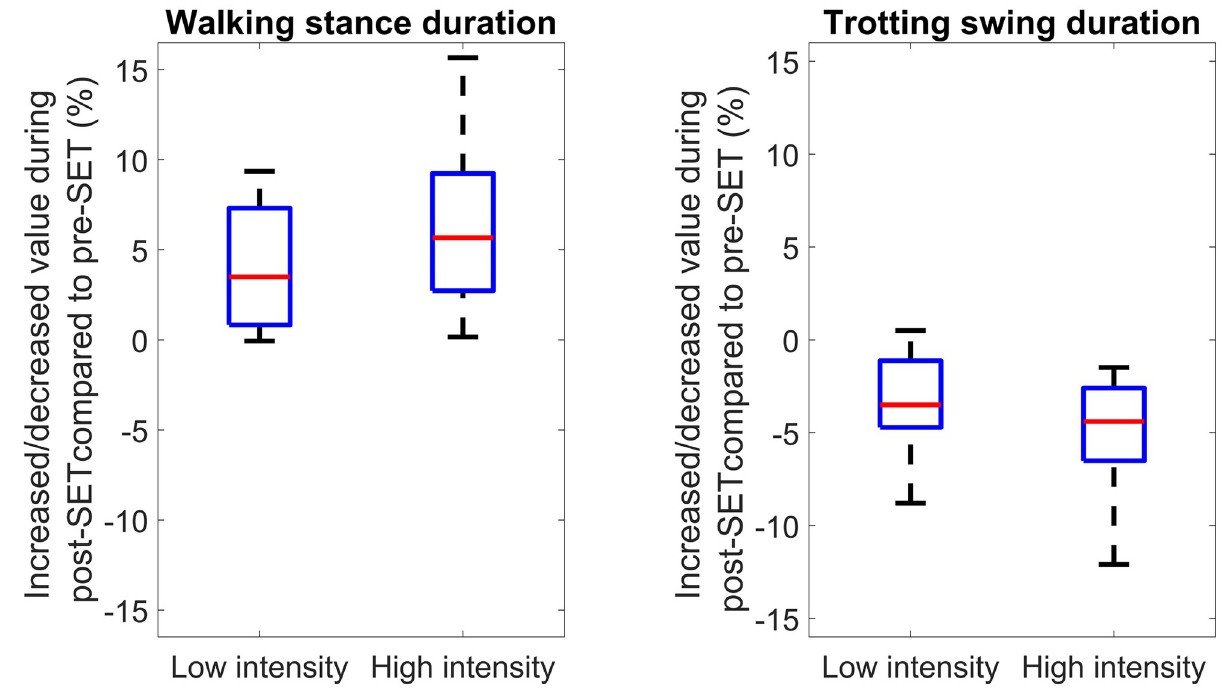
Fig 9. Comparison of biomechanical features between low and high intensity SETs (datasets 2 and 3) during walk and trot. The vertical axis represents the increase/decrease percentage of feature value during post-SET compared to pre-SET. The box represents the interquartile range, while the red line (horizontal line within the box) shows the median value. Each box (two for each plot) consists of one value per horse, which was averaged from all strides of the horse.